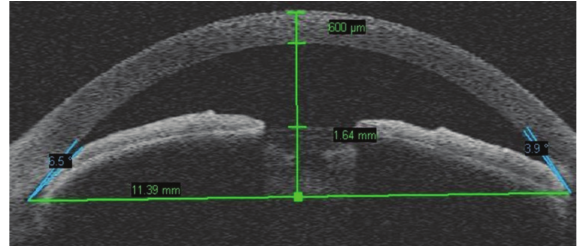
Figure 3: Quantitative assessment of narrow angle and shallow anterior chamber by AS-OCT.